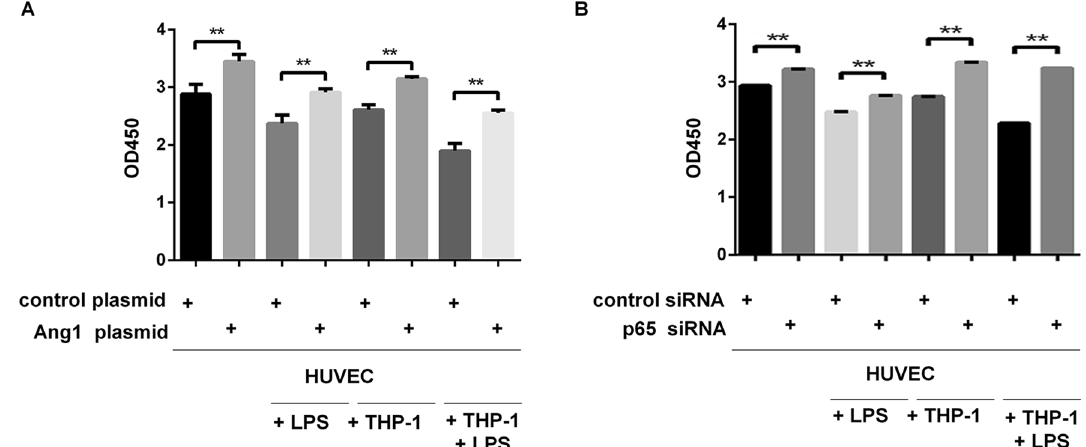
Figure 5. Either forced expression of Ang1 or knockdown of p65 significantly attenuated the impaired cell viability of HUVECs under various conditions. ( A ) HUVECs were transfected with Ang1-expressing plasmid or control plasmid for 24 h; and then the HUVECs were cultured alone with/without LPS (100 μg/mL) for 8 h, or co-cultured with THP-1-derived macrophages with/without LPS (100 μg/mL) for 8 h. Cell viability was assessed by CCK-8 method at 0 h and 8 h after LPS stimulation or co-culturing. ( B ) HUVECs were transfected with p65-targeting siRNA or control siRNA for 24 h; and then the HUVECs were cultured alone with/without LPS (100 μg/mL) for 8 h, or co-cultured with THP-1-derived macrophages with/without LPS (100 μg/mL) for 8 h. Cell viability was assessed by CCK-8 assay at 0 h and 8 h after LPS stimulation or co-culturing. n = 3 for each group. Data are presented as the ratio of 8 h/0 h cell survival rates under indicated conditions, and expressed as mean ±